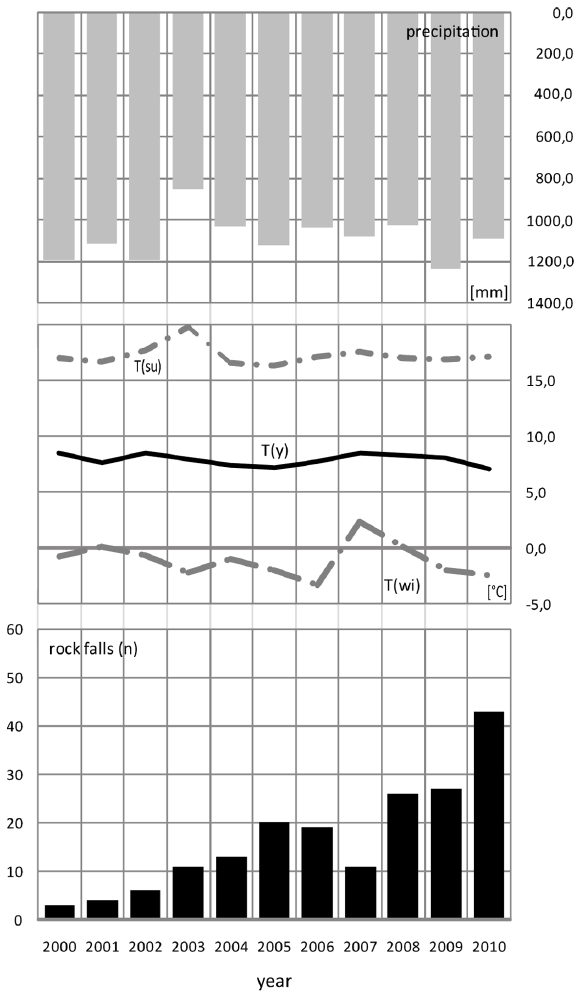
Fig. 6. Annual rockfall distribution between 2000 and 2010 to- gether with meteorological parameters. T (y) : mean annual tem- perature; T (su): mean summer temperature (June–August); T (wi): mean winter temperature (December–February). Marked rockfall decrease in 2007 is probably due to an internal inconsistency of the